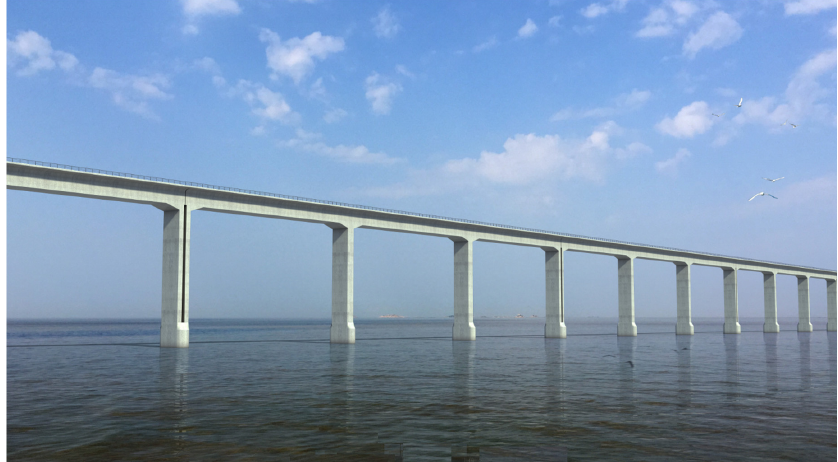
Figure 4. Design rendering of the integral rigid-frame bridge of the Fuzhou–Xiamen high-speed railway (HSR).